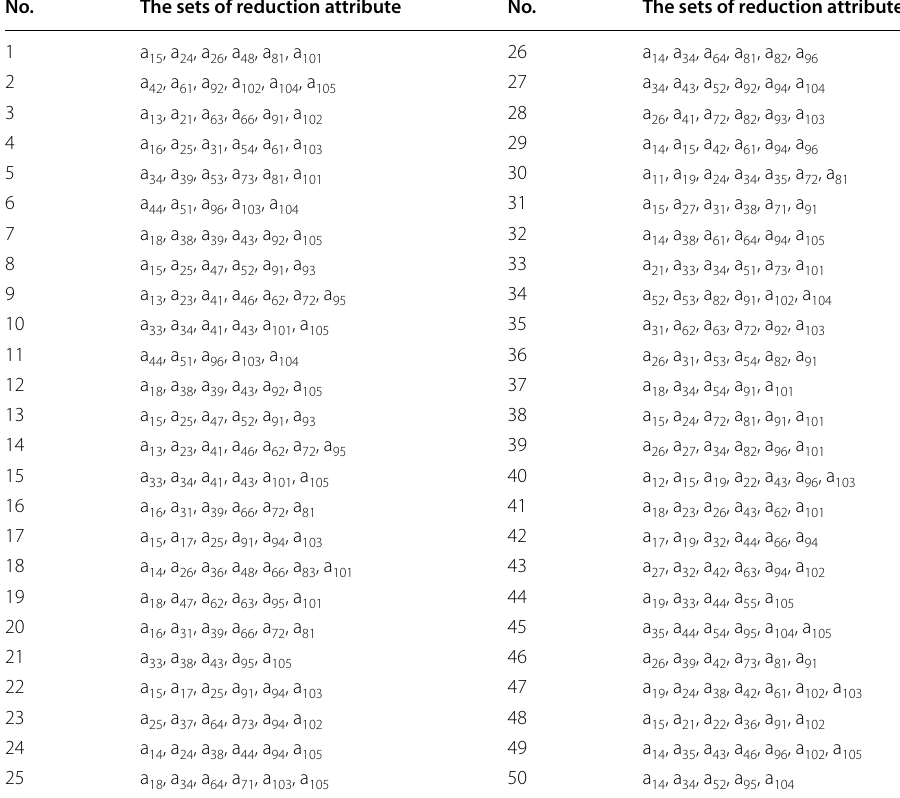
Table 5 The reduction set from the result of the rough set-based genetic